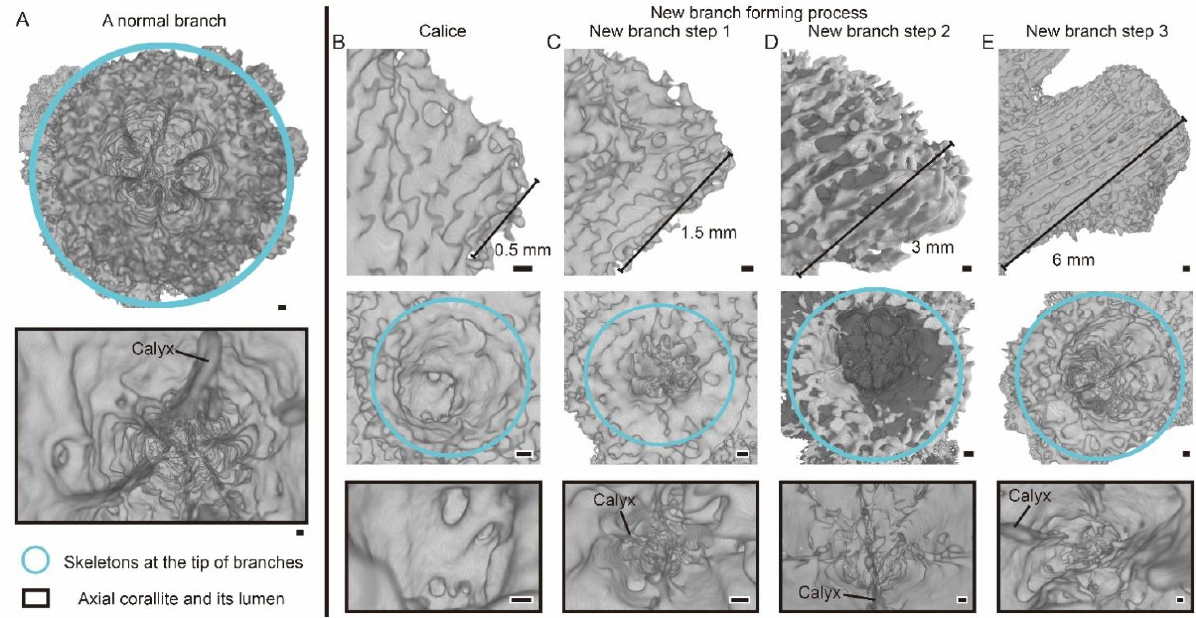
Figure 1. Structure of the axial corallite during the processes of new branch formation in A. muricata . ( A ) The axial corallite in a healthy and mature coral branch. ( B – E ) A calice transfers into an axial corallite of the new branch. Scale: 0.1